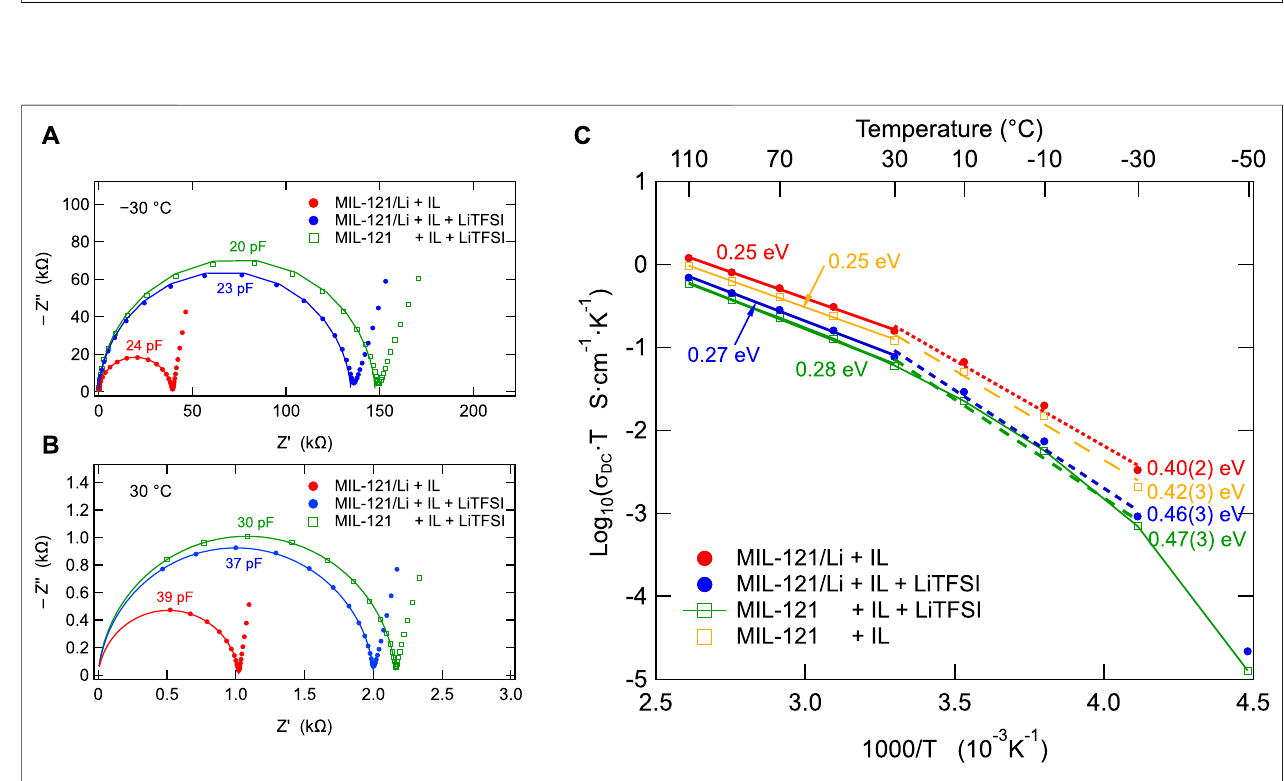
FIGURE3|(A) , (B) NyquistplotsofthehighconductivityMIL-121hybridelectrolytesat – 30 ° Candat30 ° C. (A) Thesolidlinesareobtainedby fi ttingtheimpedance data points on the shown semicircles. (B) The solid lines are obtained by fi tting the data points of the partially seen semicircles followed by simulation over an extended frequency domain up to 200 MHz. (C) Arrhenius plots and the activation energies corresponding to ion conduction in the investigated materials. Straight lines are linear data fi ts. The thin green line, corresponding to MIL-121 + IL + LiTFSI is a guide to the eye, drawn to illustrate the non-linear Arrhenius behaviour. At temperature above 30 ° C the Arrhenius plot is linear. Below 30 ° C we see a departure from linearity indicating the additional occurrence of electrical relaxation phenomena other than simple elementary ion jumps.